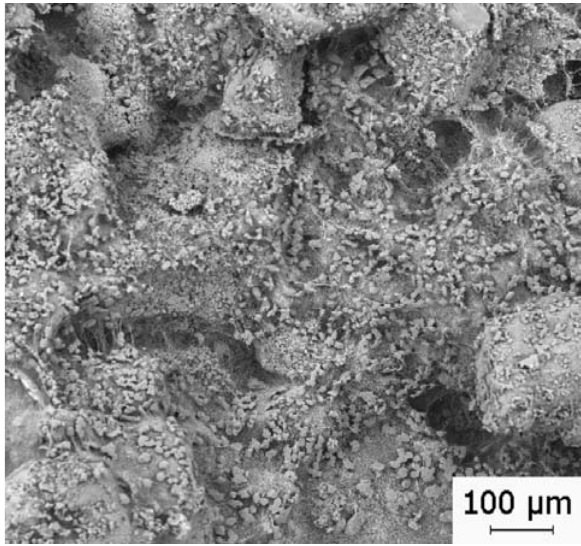
Figure 14. SEM micrograph of the aggregate/gel interface in the (L) samples (CPII-Z-32 cement/sand/5% grit) after 28 days of aging.